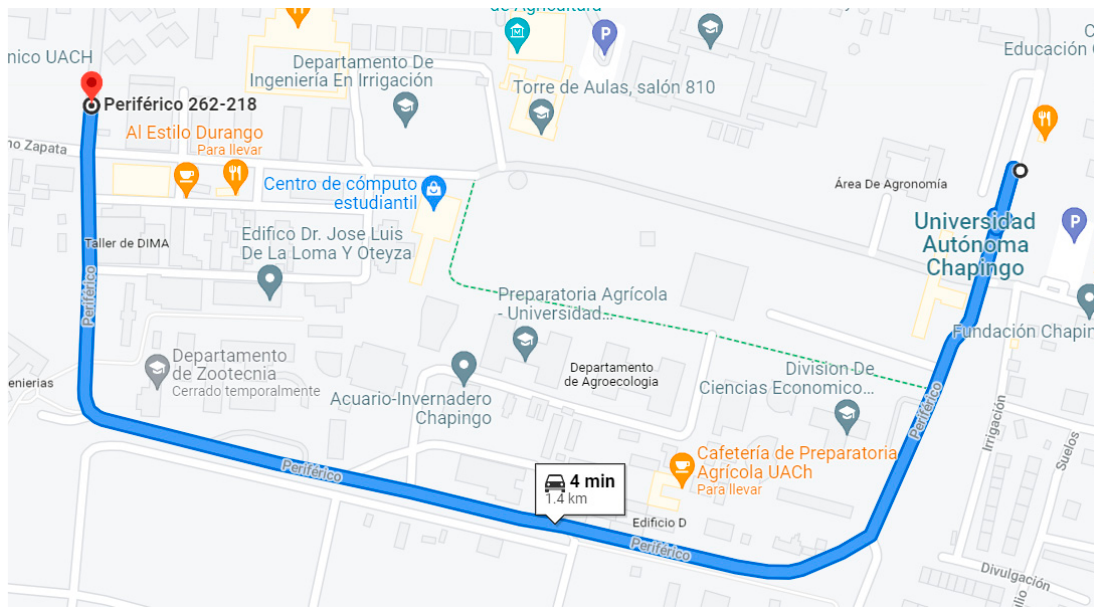
Figure 2. Test scenario with eight WiFi access points with a coverage area of 100 m.